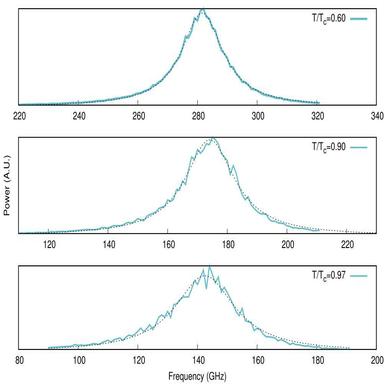
Frequency swept FMR for FePt at various temperature values. The Power spectra have been fitted via a Lorentzian (dashed) to obtain the system resonant frequency and damping.